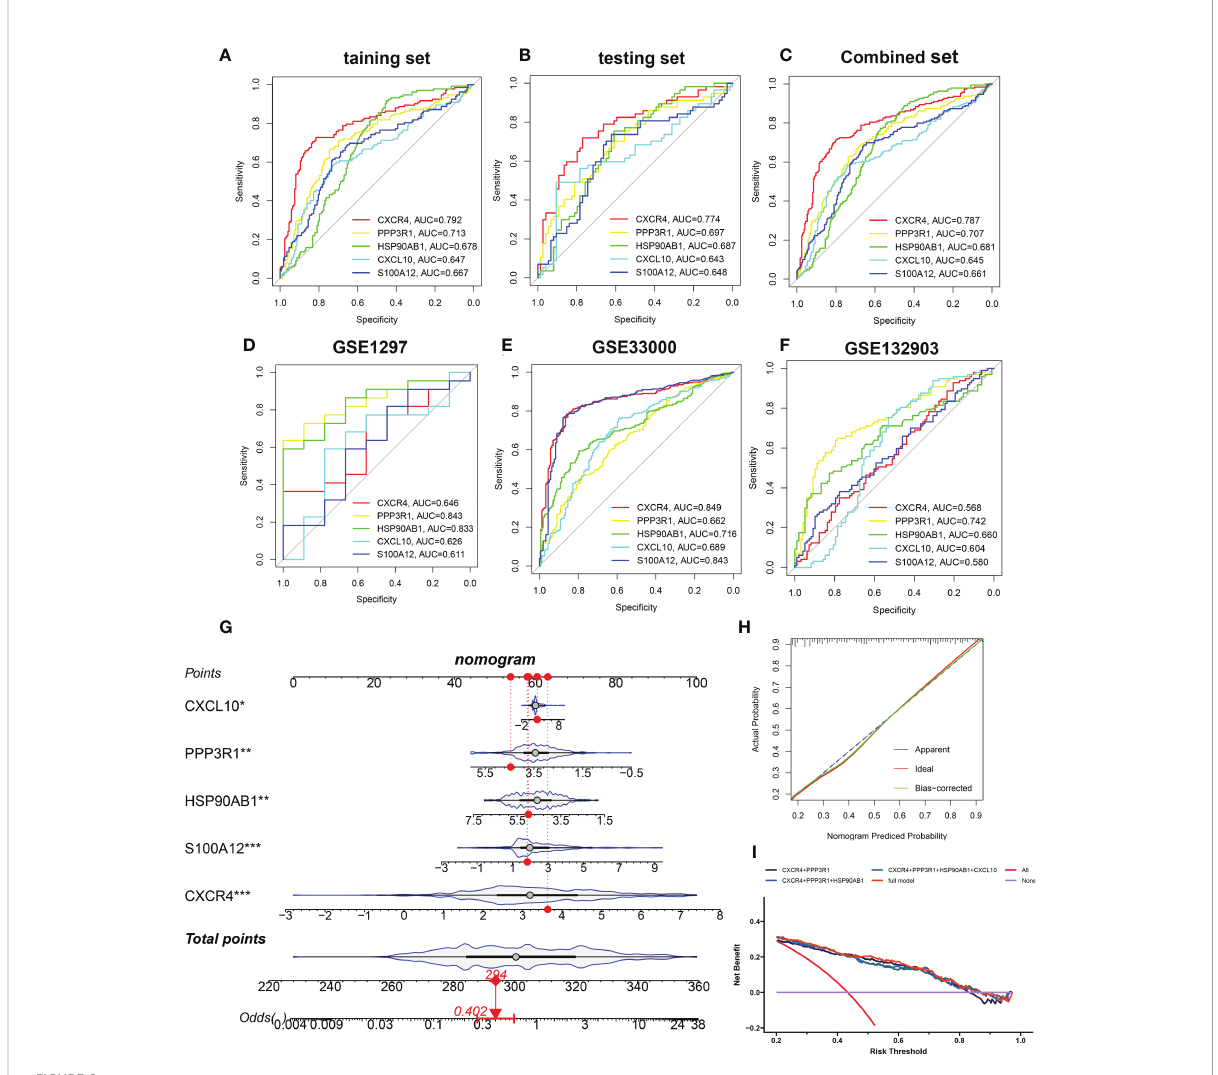
FIGURE 8 Validation of the diagnostic ef fi cacy of characteristic genes. (A – C) ROC curves showing the diagnostic performance of characteristic genes in internal datasets including training set (A) , testing set (B) , and combined set (C) . (D – F) ROC curves showing the diagnostic performance of characteristic genes in external datasets including GSE1297 (D) , GSE33000 (E) , and GSE132903 (F) . (G) Representative nomogram showing the predicted risk for AD based on feature genes. (H) Representative calibration curve showing predicted performance of the nomogram. (I) DCA showing the clinical bene fi ts of the nomogram. *p < 0.05, **p < 0.01, ***p <